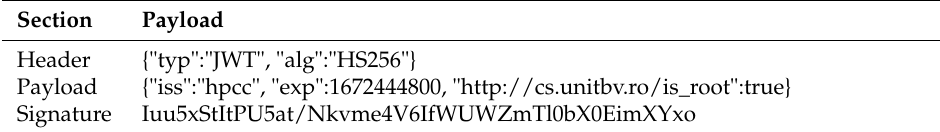
Table 1. Anatomy of a